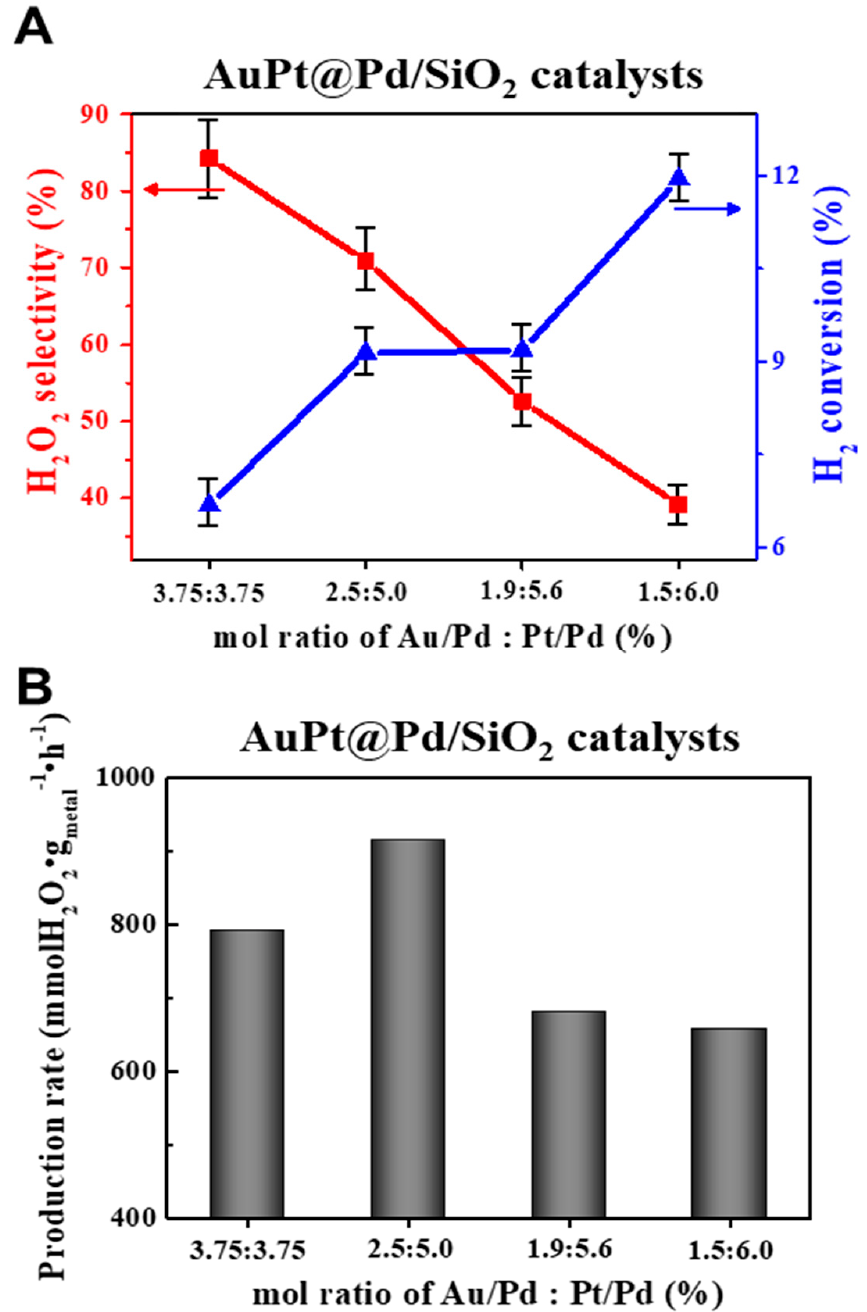
Figure 6. DSHP results for AuPt@Pd nanoparticles with varying mol% of Au and Pt in relation to the Pd core: ( A ) H 2 O 2 selectivity (red) and H 2 conversion (blue); ( B ) production rate. The error bars are added here by measuring the error of H 2 conversion from GC instrument.